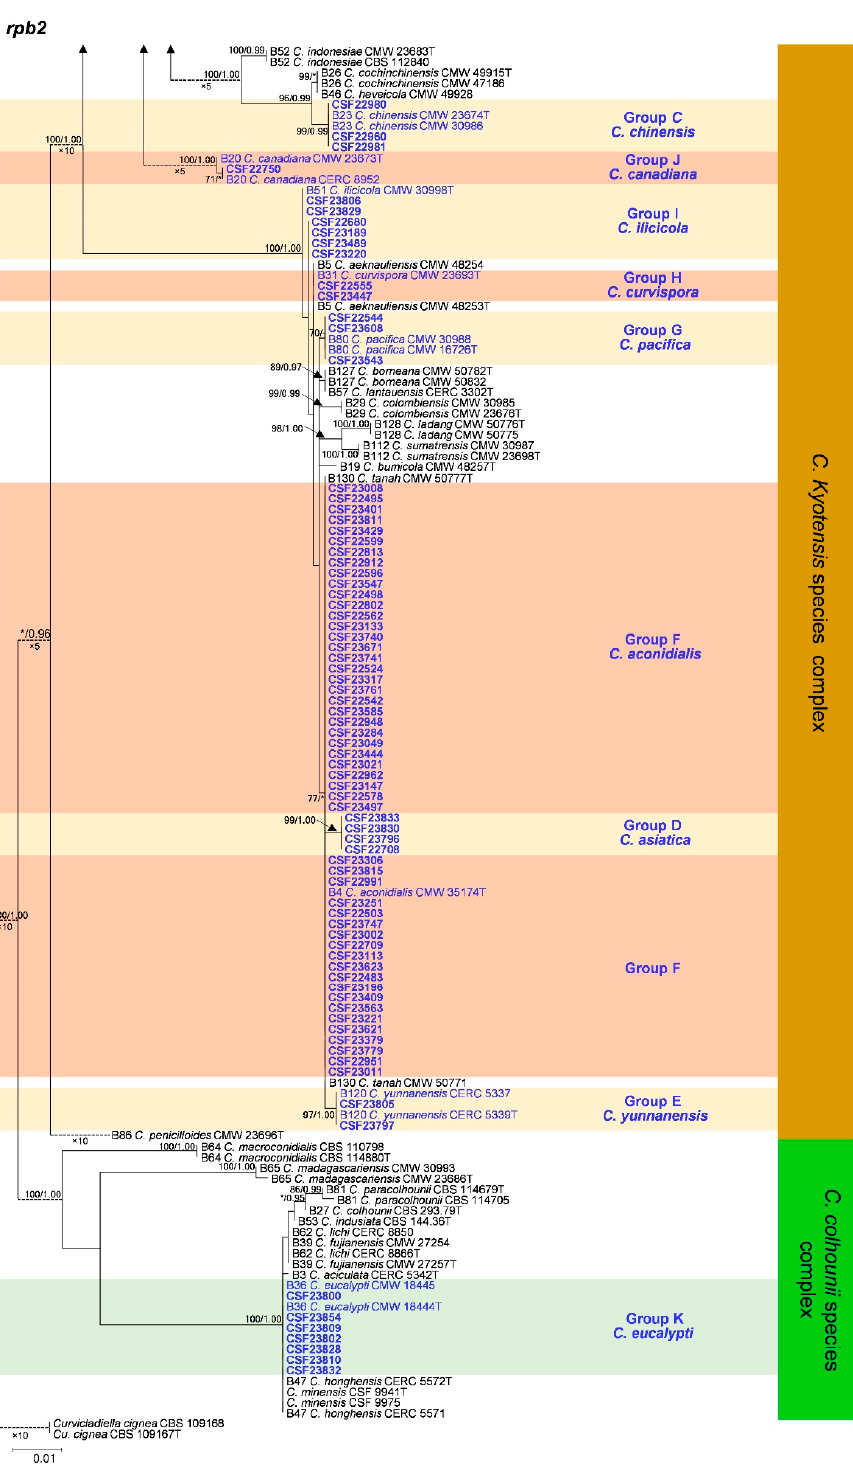
Figure A5. Phylogenetic tree of Calonectria species based on maximum likelihood (ML) analyses of the DNA dataset of the rpb2 gene sequences. Bootstrap support values ≥ 70% from ML analysis and posterior probabilities values ≥ 0.95 obtained from Bayesian inference (BI) are indicated at the nodes as ML/BI. Bootstrap values < 70% or posterior probabilities values < 0.95 are marked with “*”, and absent analysis values are marked with “-”. “*/*”, “*/-”, “-/*”, and “-/-” are not displayed. Isolates obtained in this study are highlighted in blue and bold. Ex-type isolates are indicated with “T”. The “B” species codes are consistent with the recently published results of Liu and co-authors [30]. Curvicladiella cignea (CBS 109167 and CBS 109168) was used as the outgroup